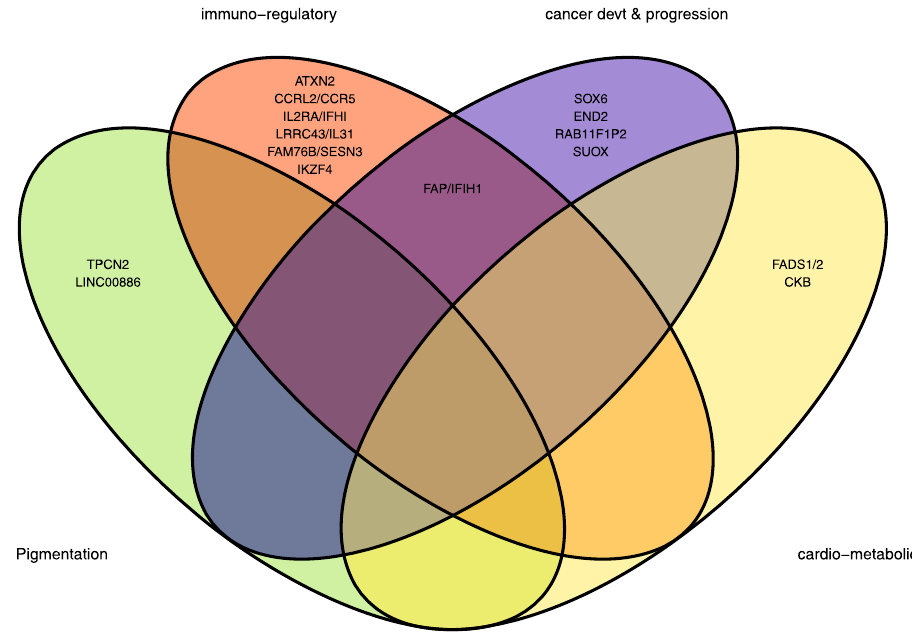
Fig. 5 | Basal cell carcinoma loci and biological pathways. The broad biological pathways included; pigmentation, immuno-regulatory, cardiometabolic and